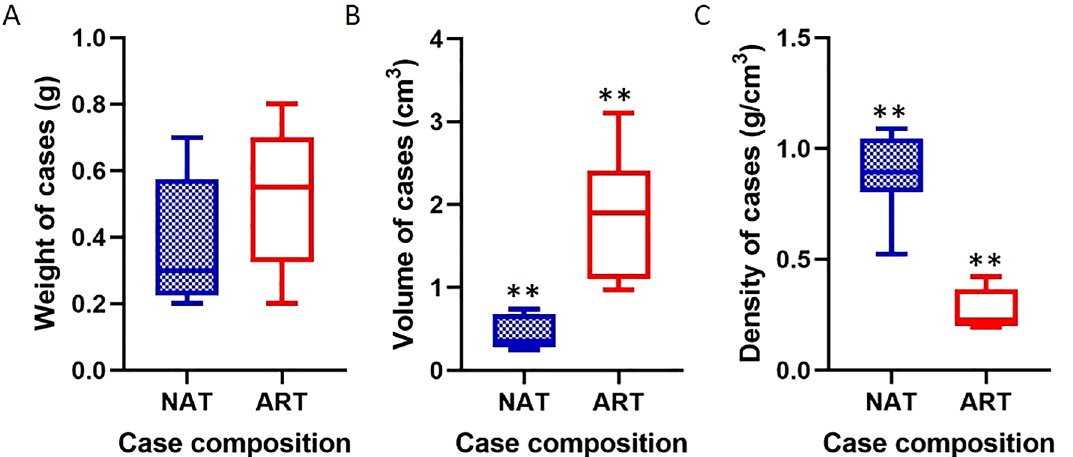
Figure 7. ( A ) Weight, ( B ) volume and ( C ) density comparisons between natural and artificial cases built by caddisflies. Bars indicate 1–99 percentile in the box plot. NAT = cases built with natural substrate; ART = artificial cases built with MIX and lMP substrates. The volume and the density between natural and artificial cases are significantly different (** p < 0.01, unpaired t-test). The images ( A ), ( B ) and ( C ) are obtained by the software GraphPad Prism (ver. 8.4.2, https ://www.graph pad.com/suppo rt/faq/prism -842-relea se-notes